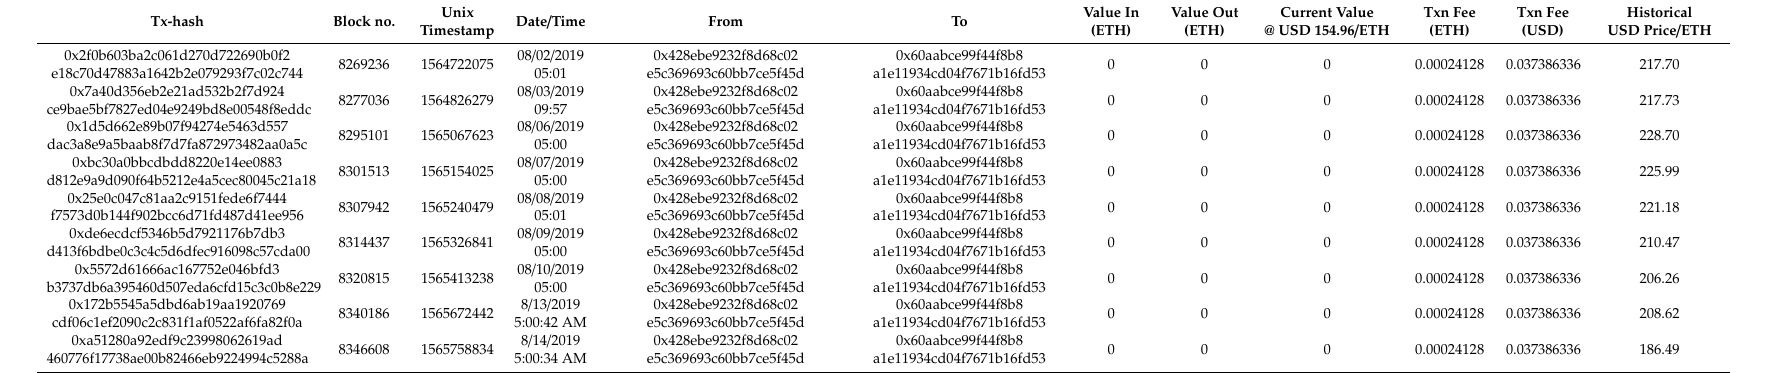
Table 2. Data written in the receiver